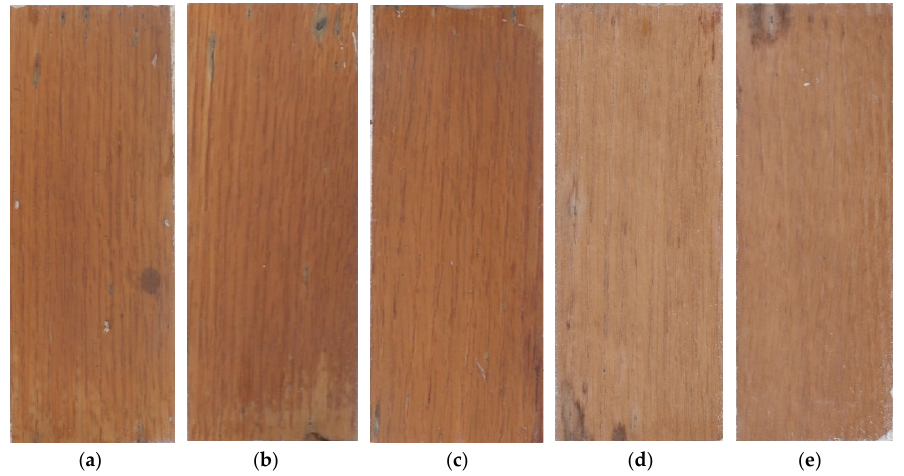
Figure 11. Appearance of solvent ‐ based spar and acrylic clear coatings on PF resin treated red oak panels exposed to the weather for 4 years: ( a ) solvent ‐ based spar/20% PF ‐ HALS; ( b ) solvent ‐ based spar/30% PF; ( c ) solvent ‐ based spar/30% PF ‐ HALS; ( d ) acrylic/30% PF; ( e ) acrylic/30% PF ‐ HALS. Note the small pin holes or cracks in the coatings and degradation (greying of the underlying wood).